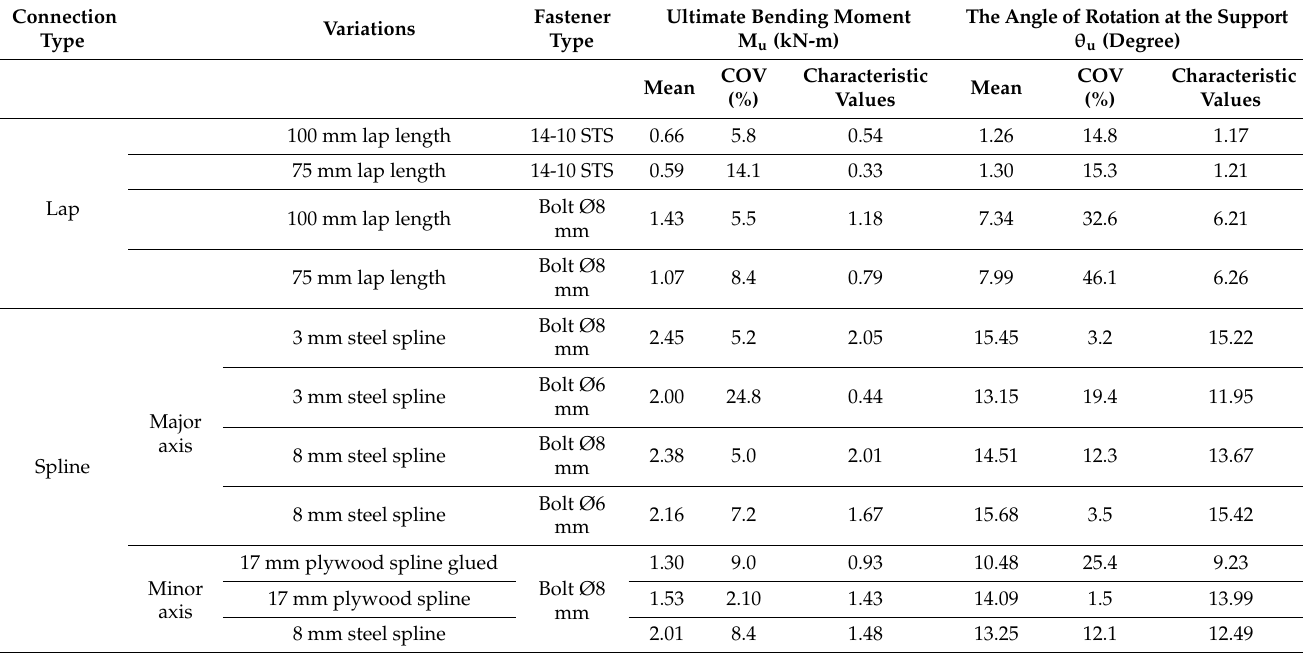
Table 4. The mean and characteristic values of the ultimate bending moments and support rotations of the CLT